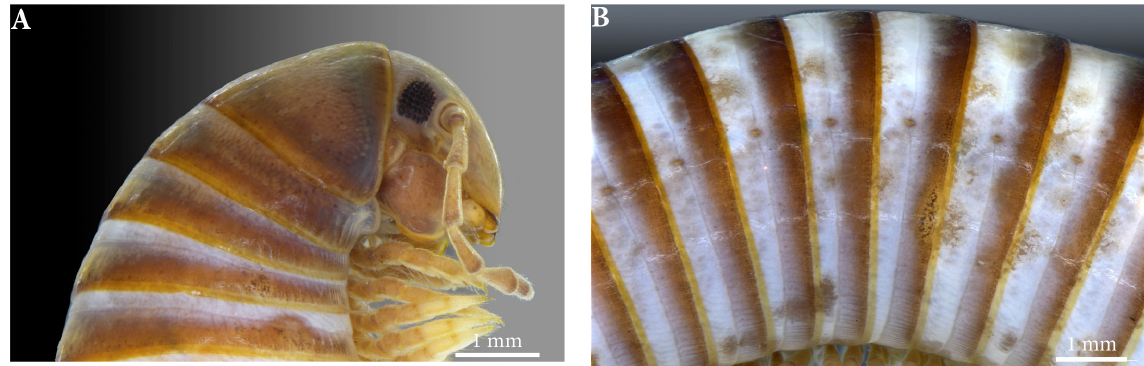
Fig. 6. Ommatoiulus camurus sp. nov. Holotype, ♂. A . Head and anteriormost body rings, lateral view. B . Mid-body rings, lateral